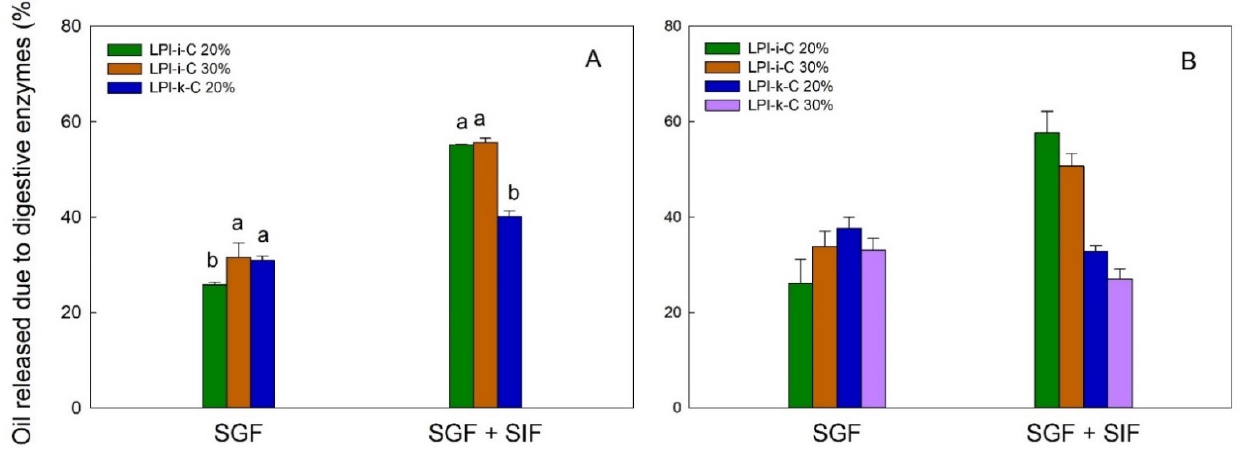
Figure 4. The release of flaxseed oil due to digestive enzymes from spray-drying ( A ) and freeze- drying ( B ) microcapsules under simulated gastric fluid (SGF) and sequential exposure to simulated gastric fluid and simulated intestinal fluid (SGF + SIF). Each value is reported as the percentage of oil released with the use of digestive enzymes minus the percentage of oil released without the use of digestive enzymes. Data represent the mean ± one standard deviation ( n = 3). The percentage on the name of the samples represents the final oil content in dried